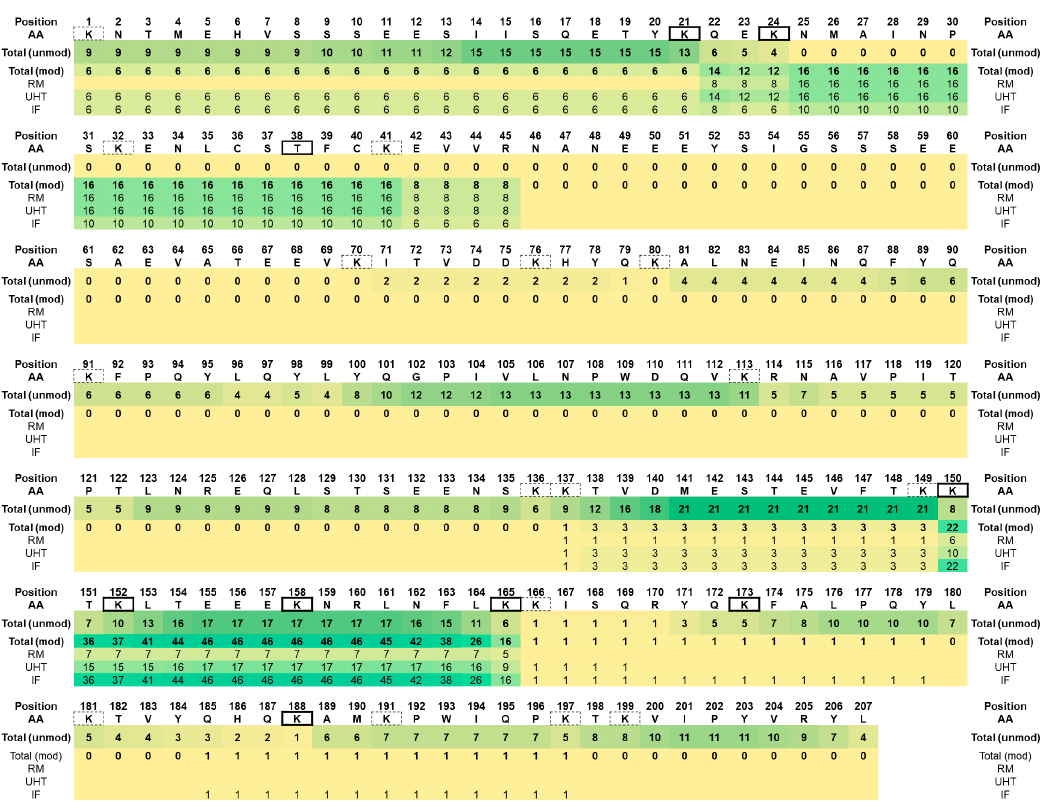
Figure 5. Sequence of α S2 -casein without the signal peptide. The numbers below the sequence indicate how many peptides containing this specific residue were detected in all samples as unmodified (unmod) and/or modified (mod) in RM, UHT milk, and IF. Lysine residues of the protein are framed with a dotted line, and modification sites are fully framed.